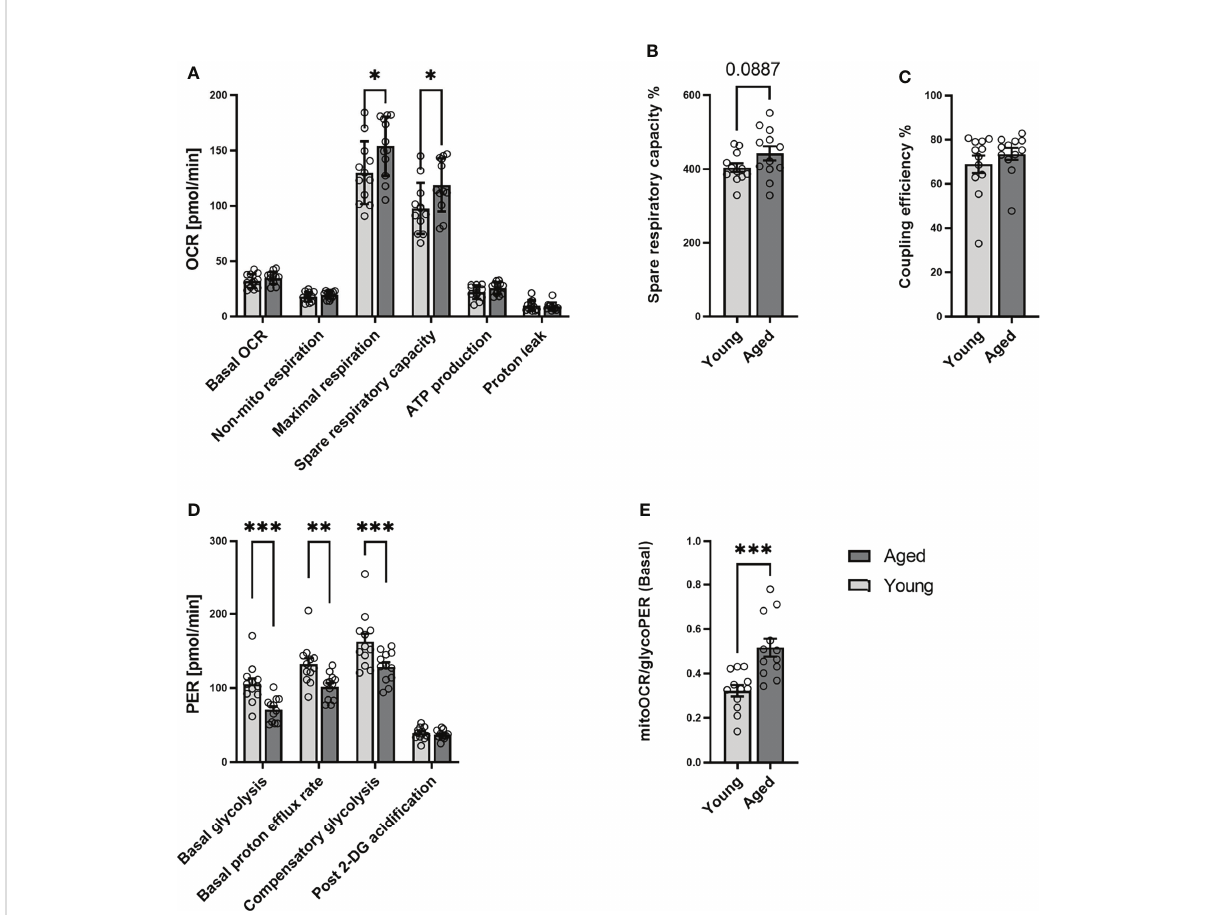
FIGURE 2 Mitochondrial pro fi le and Glycolytic pro fi le of memory CD4 + T cells in young and aged donors. Comparison of basal OCR, non-mito respiration, maximal respiration, spare respiratory capacity, ATP production, proton leak, spare respiratory capacity%, and coupling ef fi ciency in memory CD4 + T cells from young donors and aged donors (A – C) . Comparison of basal glycolysis, basal PER, compensatory glycolysis, post 2-DG acidi fi cation rate, and basal mitoOCR/glycoPER ratio in memory CD4 + T cells from young and aged donors (D, E) (mean ± SD; n = 12). In A and D, multiple comparisons were analyzed by two-way ANOVA, with the Bonferroni multiple-comparison post hoc test. In B, C, E, a Mann- Whitney test was performed. *P<0.05, **P<0.01; ***P<0.001. OCR, oxygen consumption rate; PER, proton ef fl ux